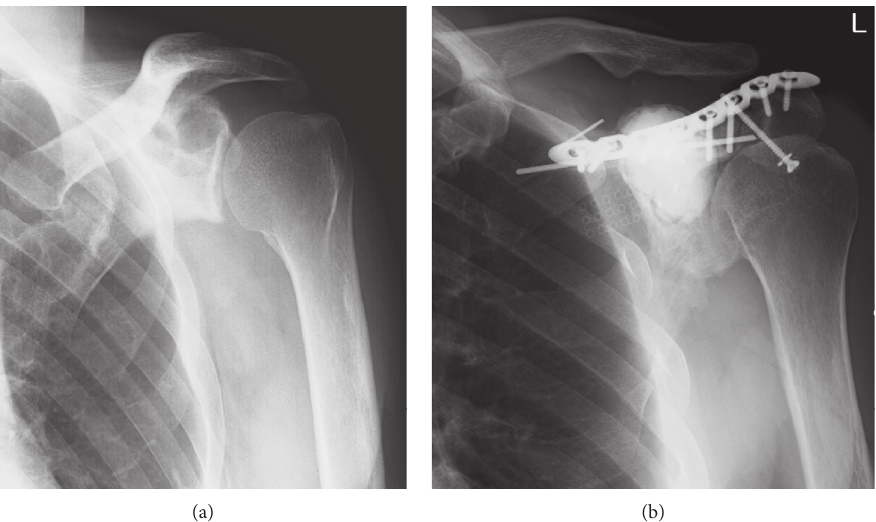
Figure 4: Case #3: 40-year-old male with grade 2 chondrosarcoma of the left scapula. (a) Preoperative X-ray and (b) 4 years after treatment with osteoarticular extracorporeal irradiated